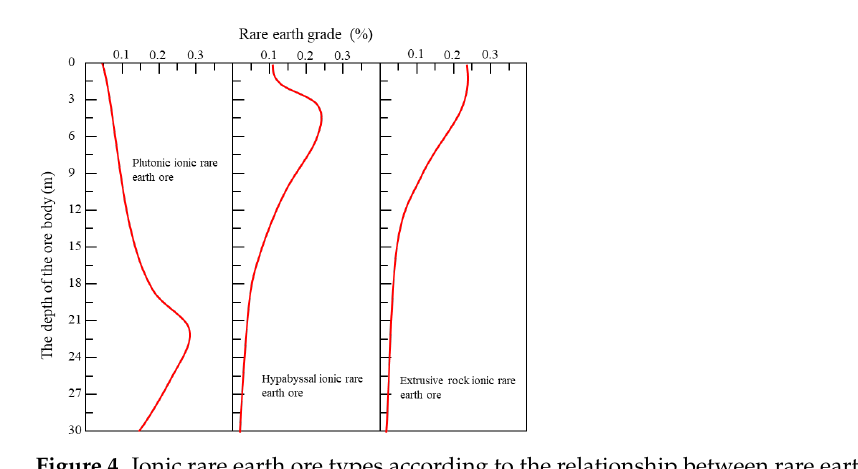
Figure 3. Structural characteristics of different weathering crusts: ( a ) Weathering crust of Zudong muscovite alkali feldspar granite in Jiangxi Province, ( b ) Weathering crust of Liutang rhyolite in Guangxi Province, and ( c ) Weathered crust of Getengzui metamorphic tuff in Jiangxi Province [15].